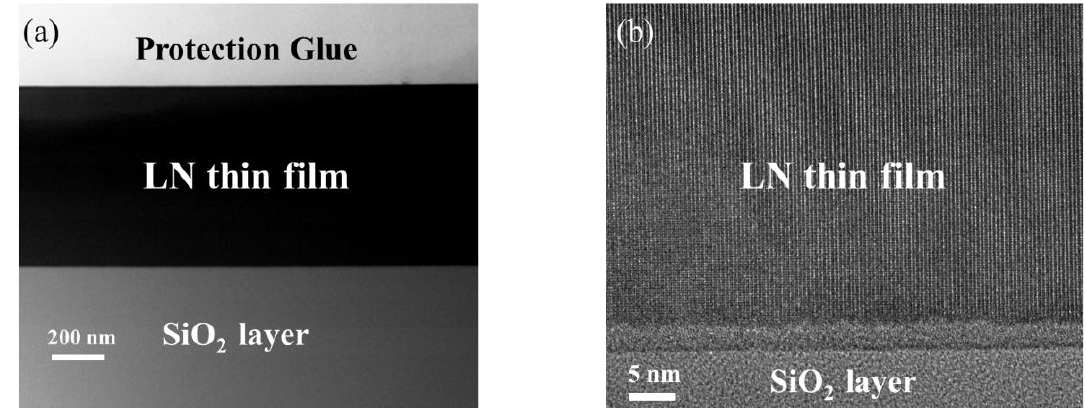
Figure 2. Cross section of grinded LNOI observed by TEM ( a ) and high-magnification TEM ( b ). HRXRD with Cu K α1 (λ = 1.54056 Å) as the X -ray radiation source was used to in-